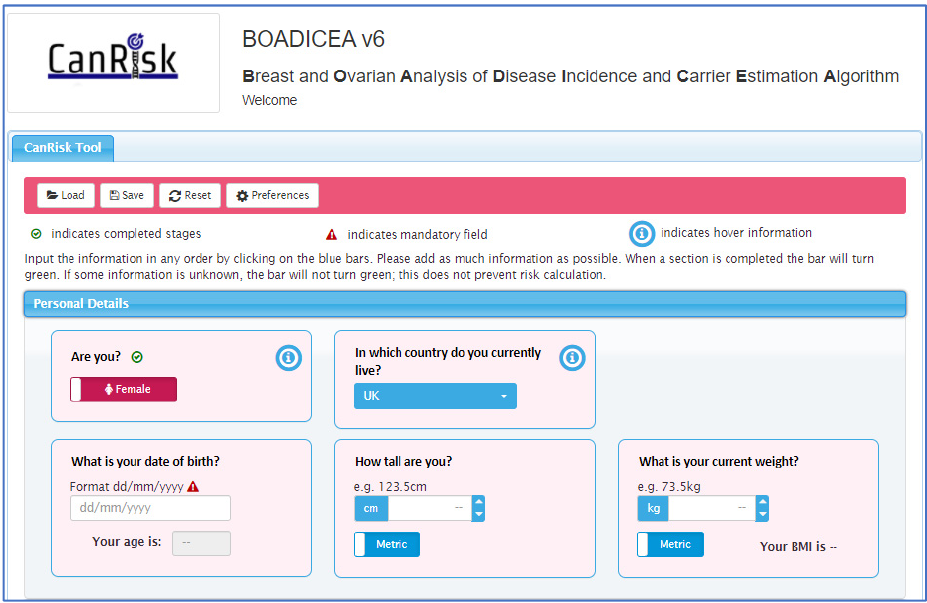
Figure 2. CanRisk tool, detailed view of one topic area.